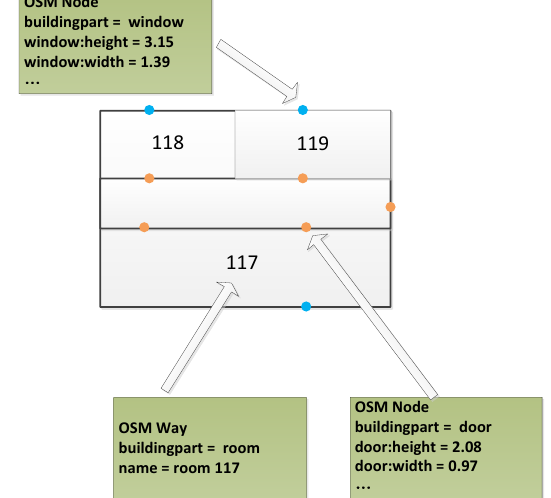
Figure 1: An example of using IndoorOSM to model rooms with windows and doors. The OSM nodes that represent windows and doors are coloured in blue and in brown respectively.